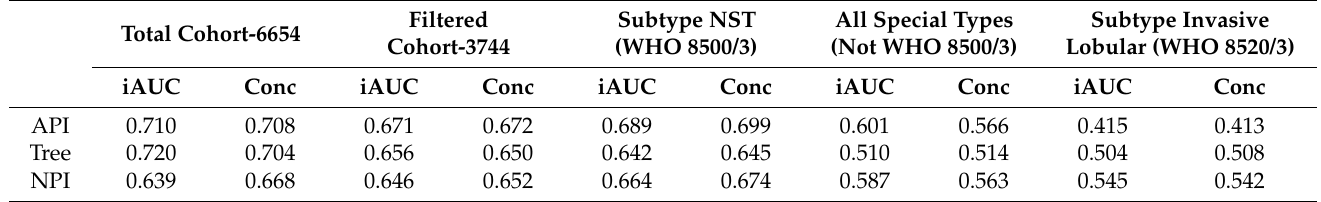
Figure 2. Survival tree of the training set for the filtered cohort–3744 patients (primary cancers that were unifocal, estrogen receptor-positive, Her2-negative with an age ≤ 70 years ( n = 3744)). Table 4. iAUC and concordance of the API (Cox regression), the survival tree model and the NPI for the test sets of the different cohorts.